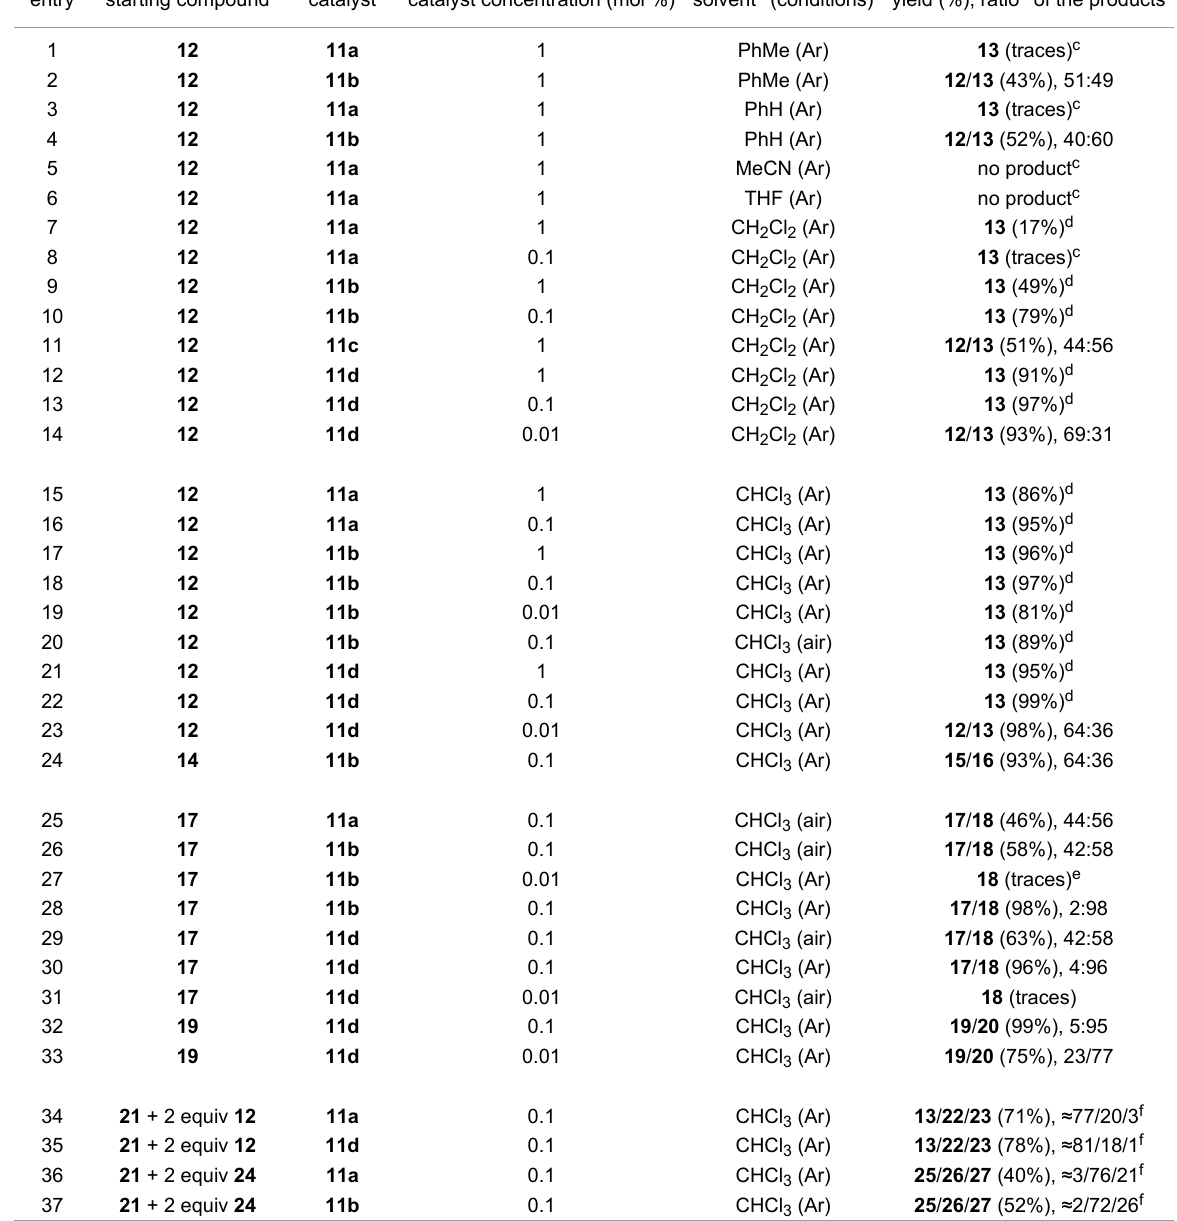
Table 3: Reaction conditions and yields of the metathesis products.